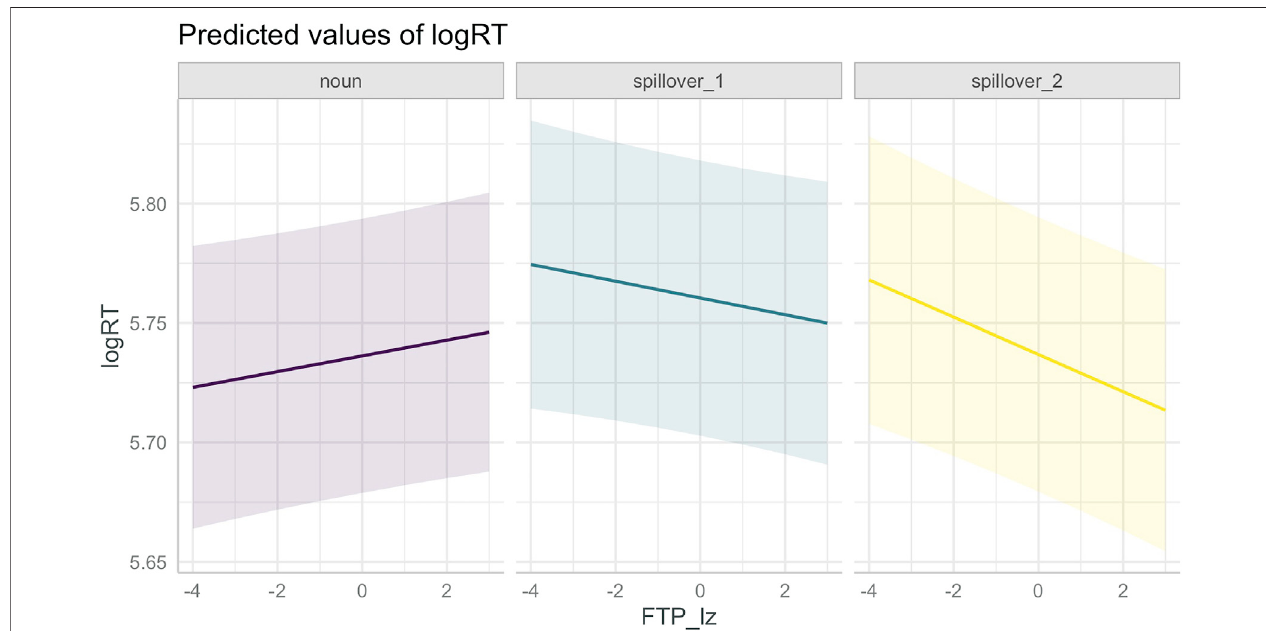
FIGURE 8 | Interaction between (log-transformed, z-scored) forward transition probability and position in the sentence (noun in associated modi fi er-noun bigram, fi rst and second spillover words).